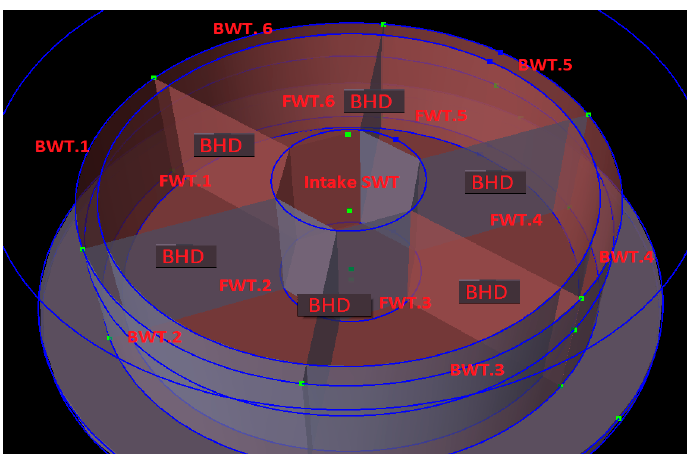
Figure 16. Tank arrangement.